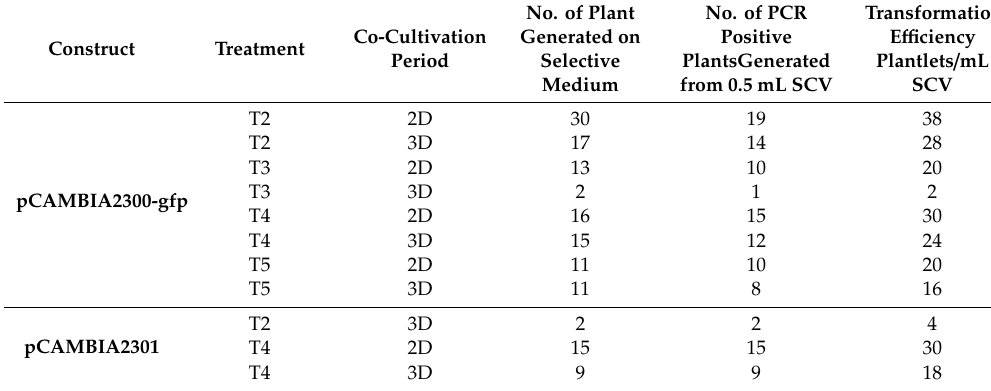
Table 3. Transformation efficiency of embryogenic cell suspension (ECS) of plantain cultivar Obino l’Ewai with varying concentration of acetosyringone and co-cultivation period.